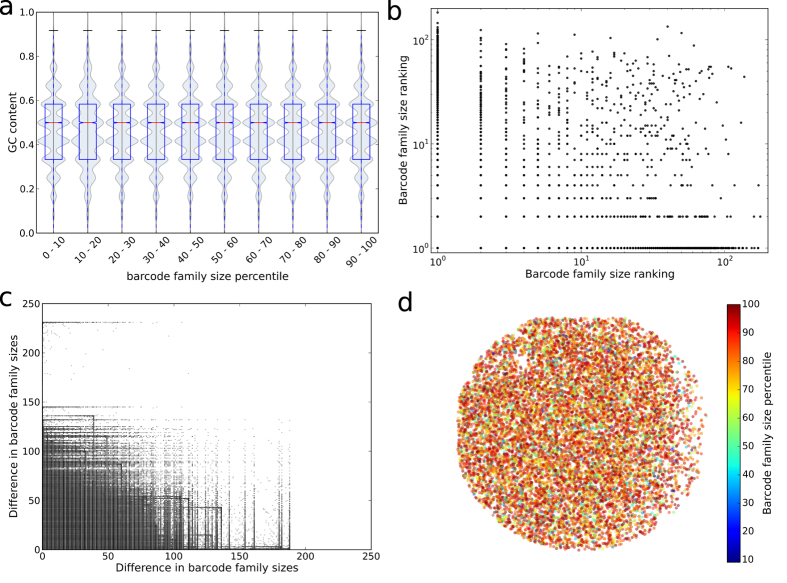
(a) Distribution of GC content of the 12-nucleotide random barcodes by barcode family size percentile. Data from a sequence run of healthy volunteer PBMC TCRs. (b)The correlation between the barcode family size ranking in any pair of runs for those barcodes that occur in more than one of the eight monoclonal KT2 TCR sequencing runs (Protocol A) in this study (R-squared <0.0003). Ranking is ascending, and barcodes that have the same family size in a run are given the same ranking. There is no gap introduced in rankings when more than one barcode occupies a particular ranking, as such for small barcode family sizes ranking is equivalent to barcode family size. (c) For those pairs of barcodes that appear together in any pair of the eight KT2 sequencing runs (Protocol A) in this study, the relationship between the difference in barcode family sizes in one run and in the other. R-squared <0.0004. (d) Position of TCR molecules on the flowcell, coloured by barcode family size percentile. Representative example of a single frame from one flow cell from a sequencing run in this study.